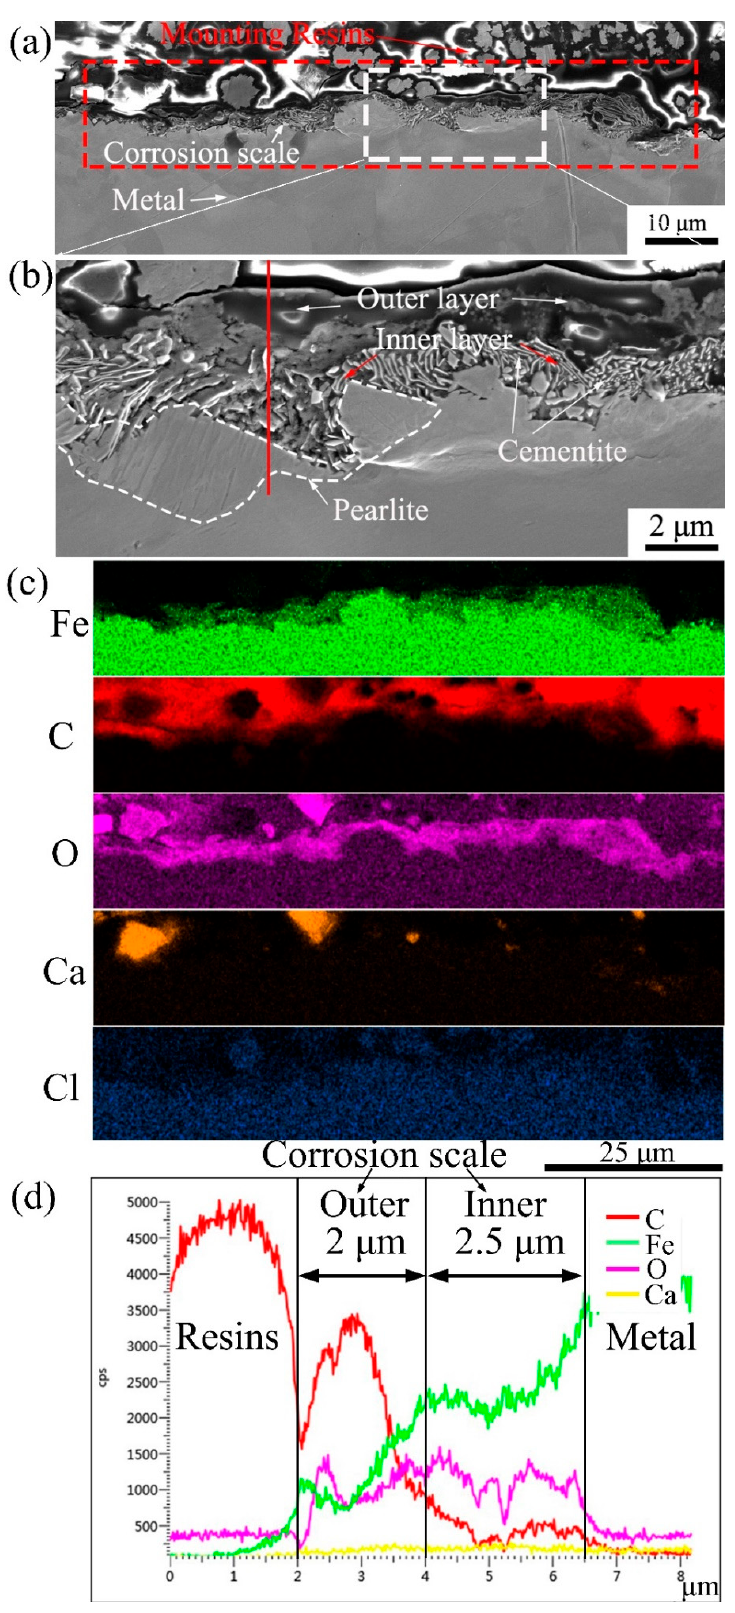
Figure 7. ( a ) SEM image of cross-section of L245N standard steel after 2 days of testing; ( b ) the enlarged SEM image of the area in the white box marked in ( a ); ( c ) EDS mapping of the area in the red box in ( a ) and ( d ) EDS compositional profile along the red line marked in ( b ).